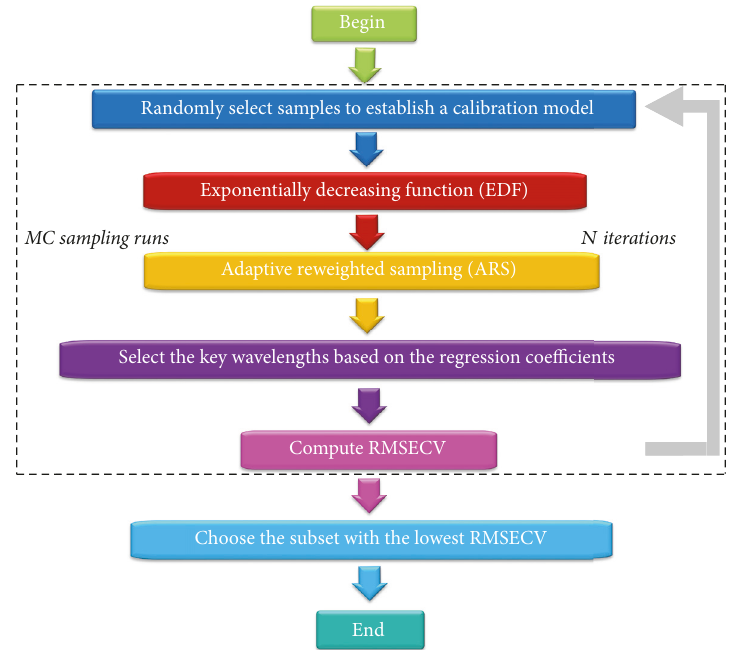
Figure 1: The flowchart of the competitive adaptive reweighted sampling algorithm.